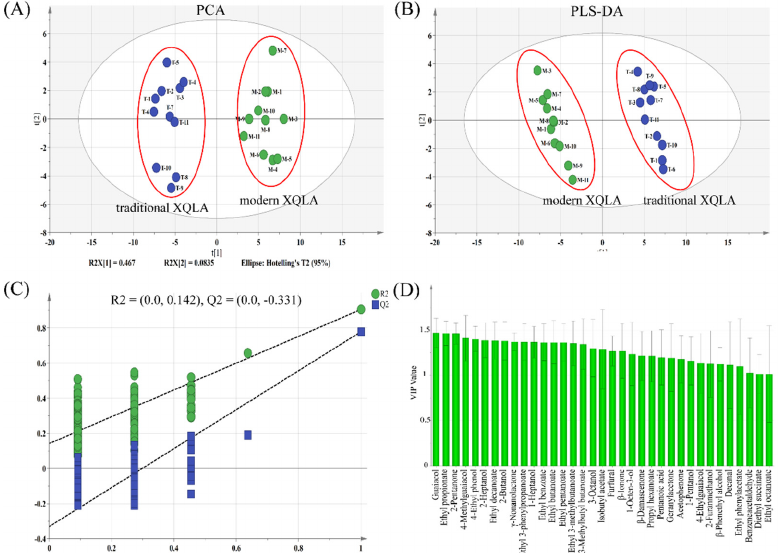
Figure 3. ( A ) PCA (Principal component analysis) scores scatter plot for modern xiaoqu Baijiu and traditional xiaoqu Baijiu samples (PC1 46.7%, PC2 8.35%). ( B ) PLS-DA (partial least squares discriminant analysis) scores scatter plot for different samples (R2Y = 0.993 and Q2 = 0.978). ( C ) The validate model of the PLS-DA model. ( D ) The variable importance for projection (VIP) plot (VIP > 1).